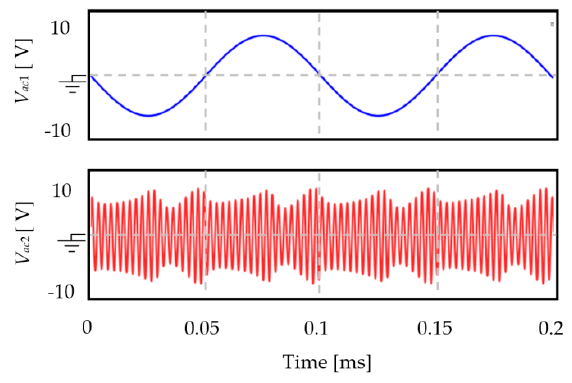
Figure 7. Load voltage of two resonant branches.